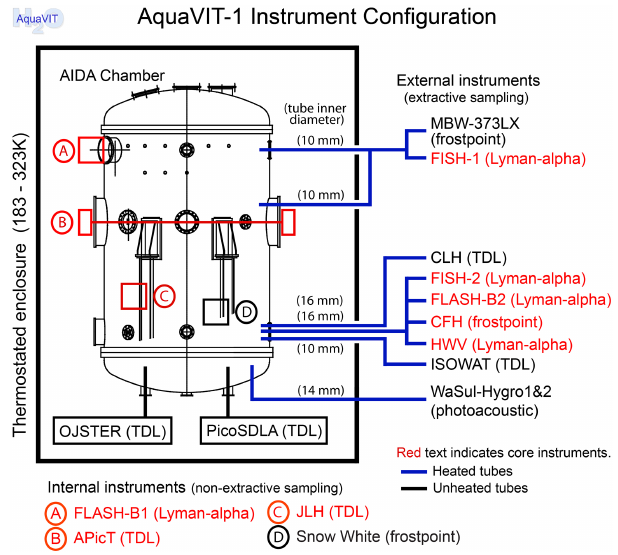
Figure 2. AIDA chamber configuration of the AquaVIT-1 instru- ments in Table